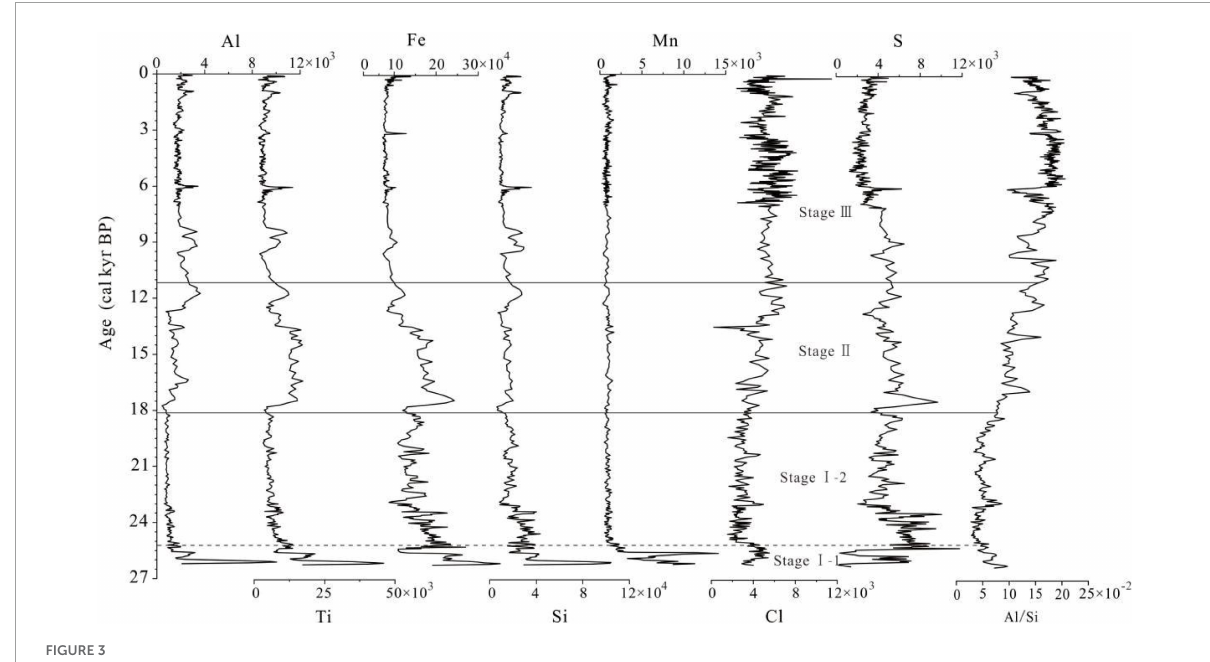
FIGURE3 Scanning intensity and chromaticity curves of elements from the GC core.